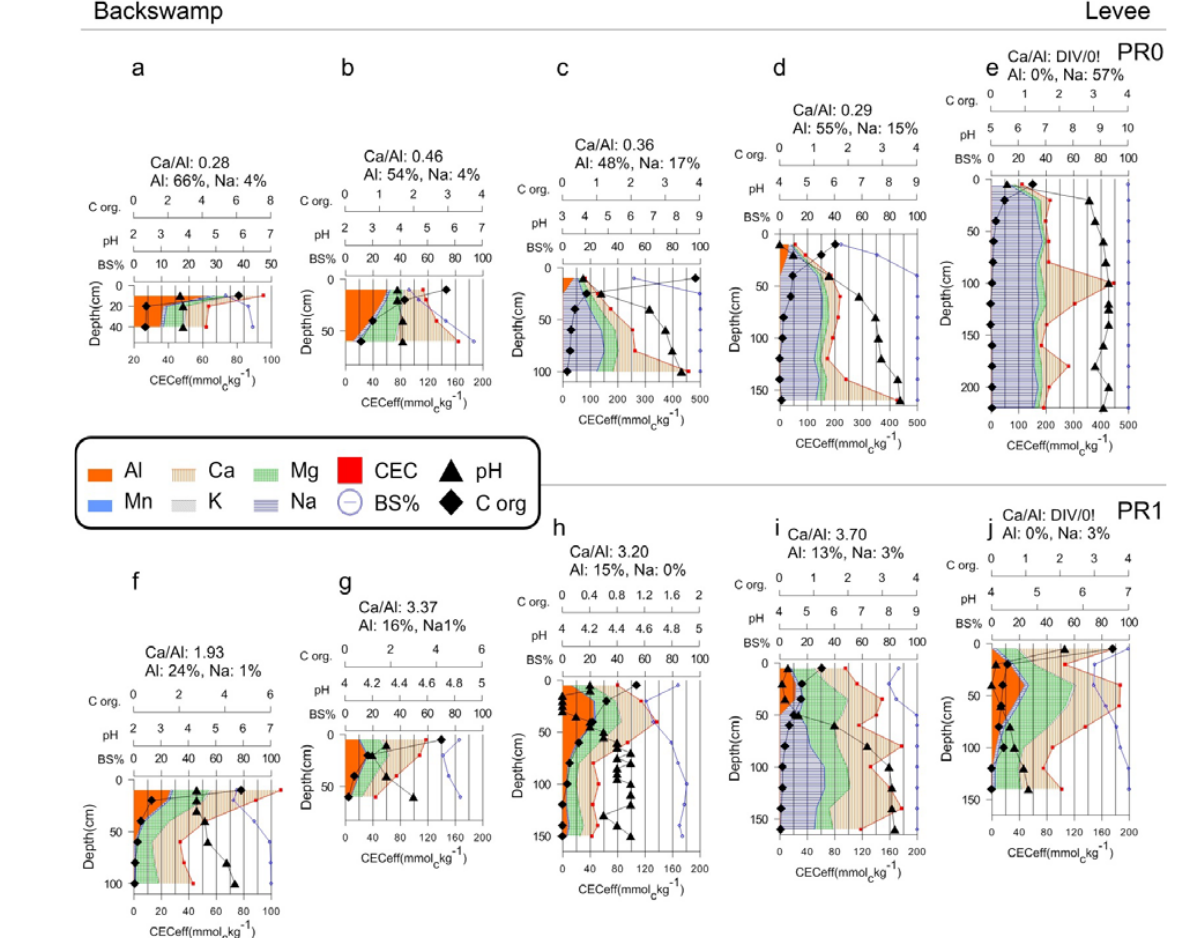
Figure 8. Geochemistry of the soil profiles of the PR0 and PR1 transects.